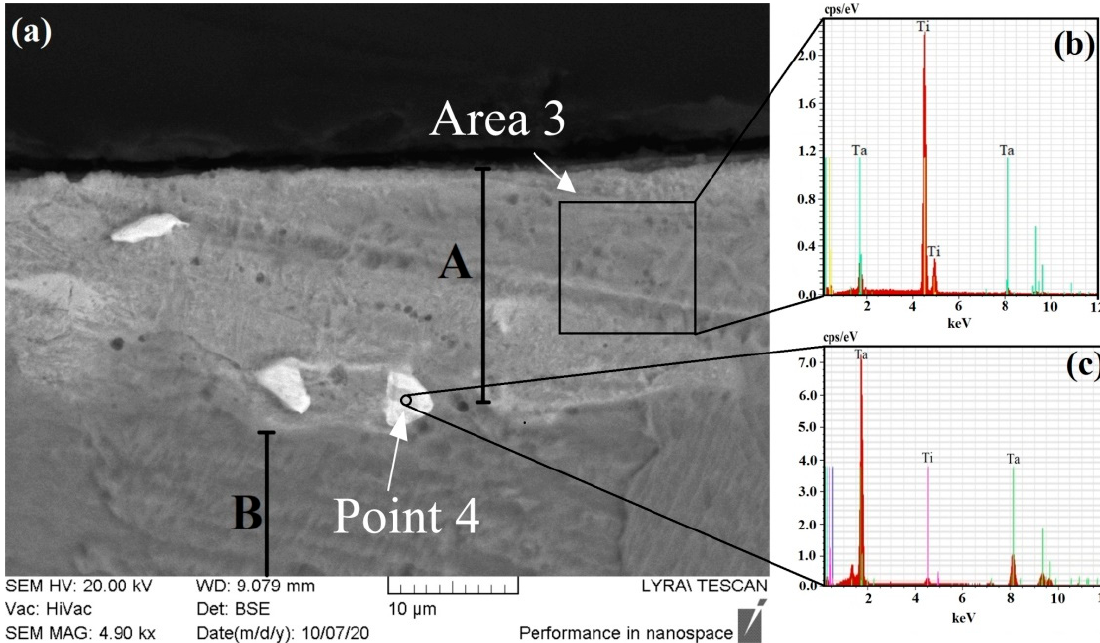
Figure 3. A cross-sectional SEM image of the sample processed with a beam power of 1250 W ( a ) and corresponding EDX spectra taken from different regions ( b , c ).